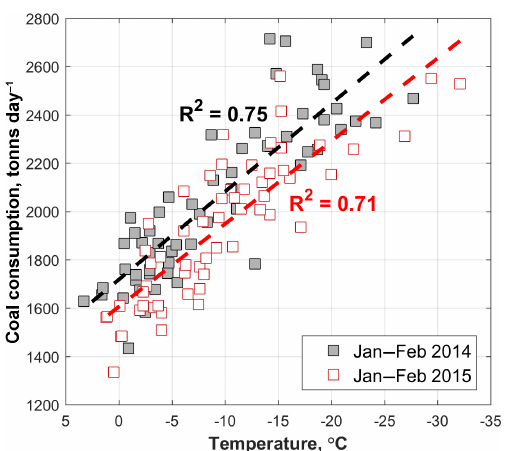
Figure 10. Daily coal consumption as a function of the mean air temperature for the winters of 2014 and 2015. Data were provided by the administration of Apatity combined heat and power